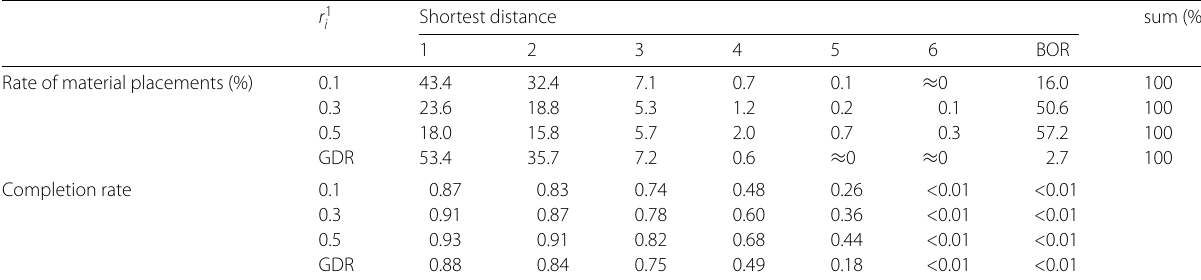
Table 5 Distance to the installation agents and associated task completion rate in Exp.